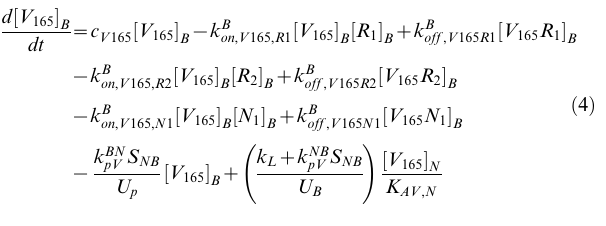
Table 1. Geometric parameters for the tissue (human vastus lateralis muscle).